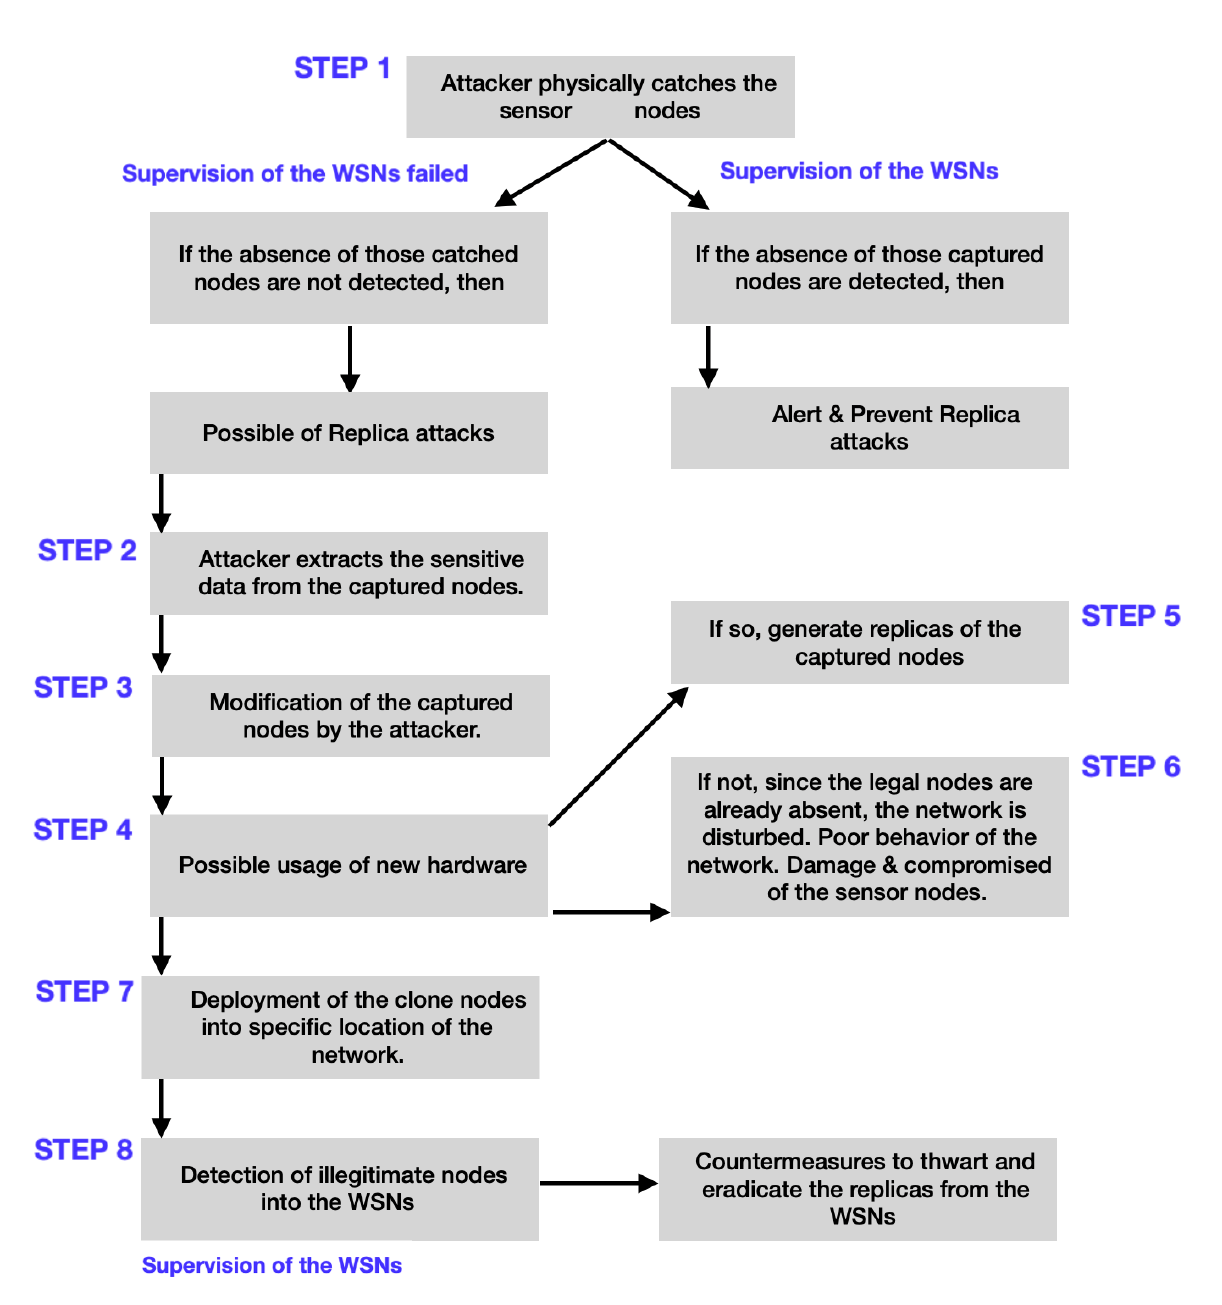
Figure 5. Procedures of creating a replication attack in static